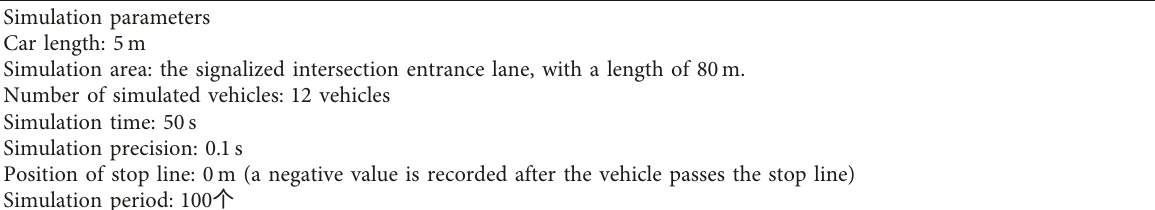
Table 2: The simulation parameters in 0% heavy vehicles scenario.